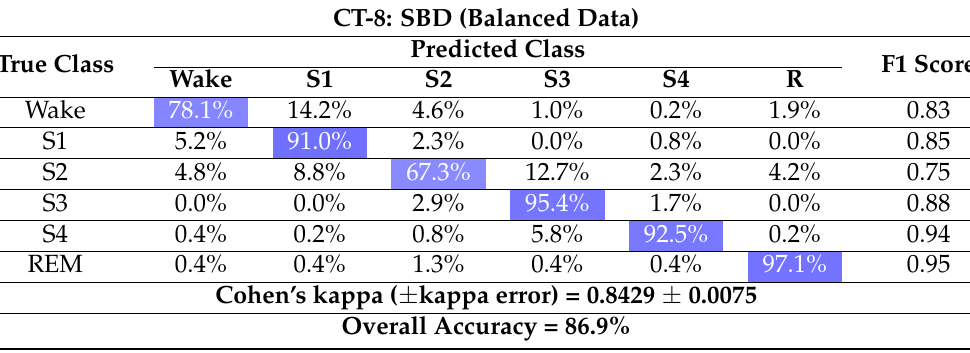
Table 24. Confusion matrix corresponding to sleep stage classification of sleep-breathing disorder patients with balanced data using the EBT classifier with 10-fold